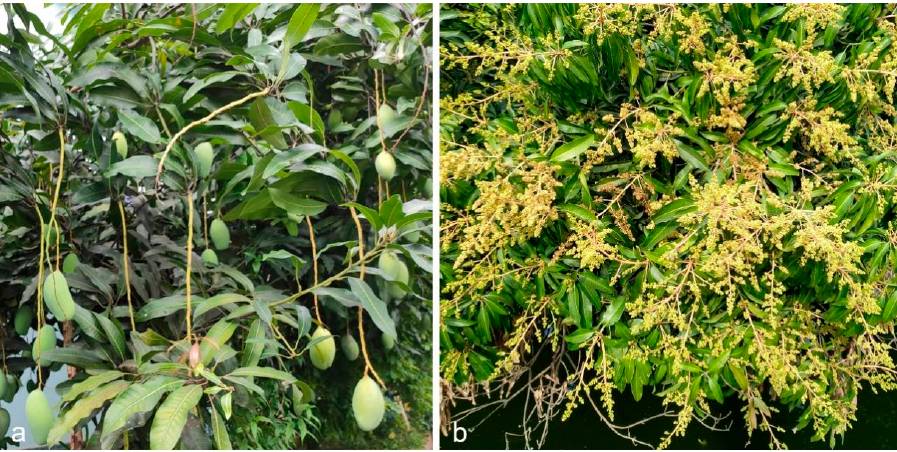
Figure 1. ( a , b ) Mango fruits and flowers with healthy leaves in Honghe, Yunnan Province, China